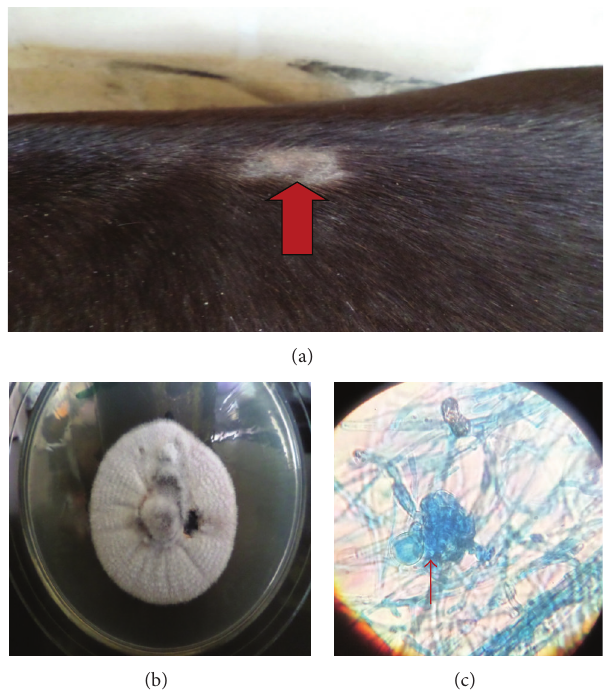
Figure 1: Single area of patchy alopecia in the saddle region of a horse caused by T. equinum (a), colony of T. equinum (8 days) (b), and nodular bodies and microconidia of T. equinum (c) (LCB × 400).